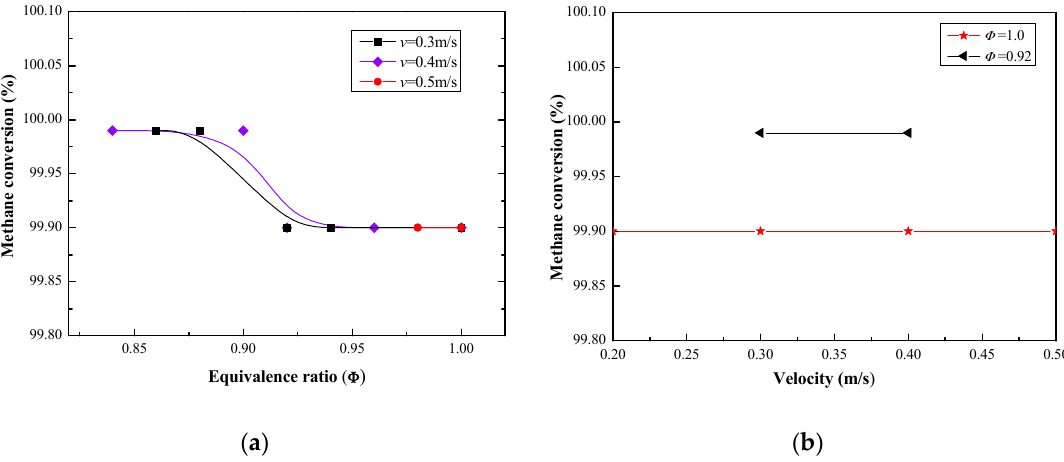
Figure 9. The conversion of methane catalytic combustion: ( a ) Different equivalence ratios; ( b ) different velocities.